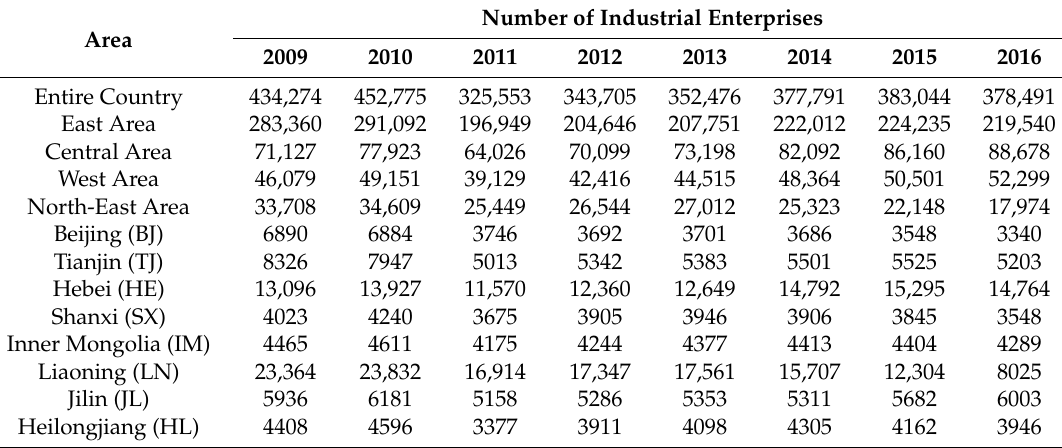
Table 2. Number of industrial enterprises in various provinces in China